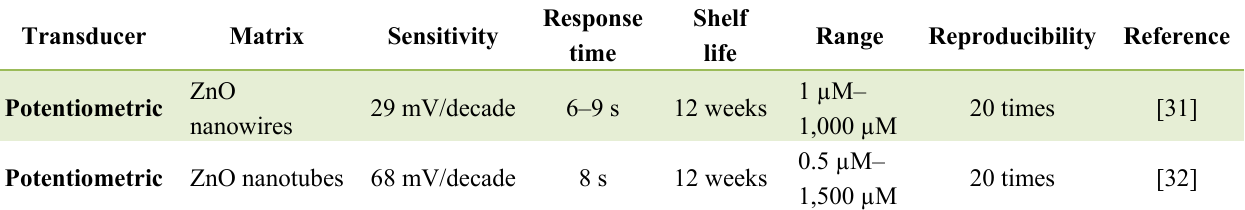
Table 1. Comparison of some uric acid sensors based on different ZnO nanostructures.